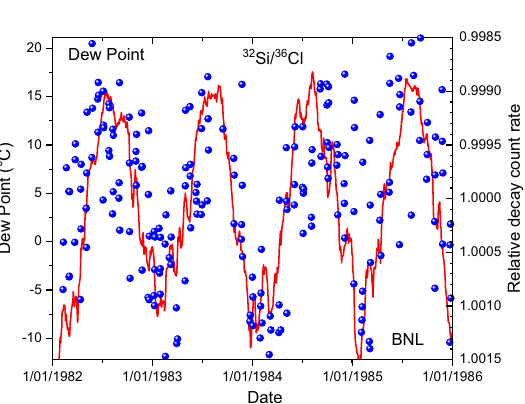
Figure 6. Relative deviations on measured decay rate ratios of 32 Si/ 36 Cl at BNL (dots), compared to dew point data from a nearby weather station